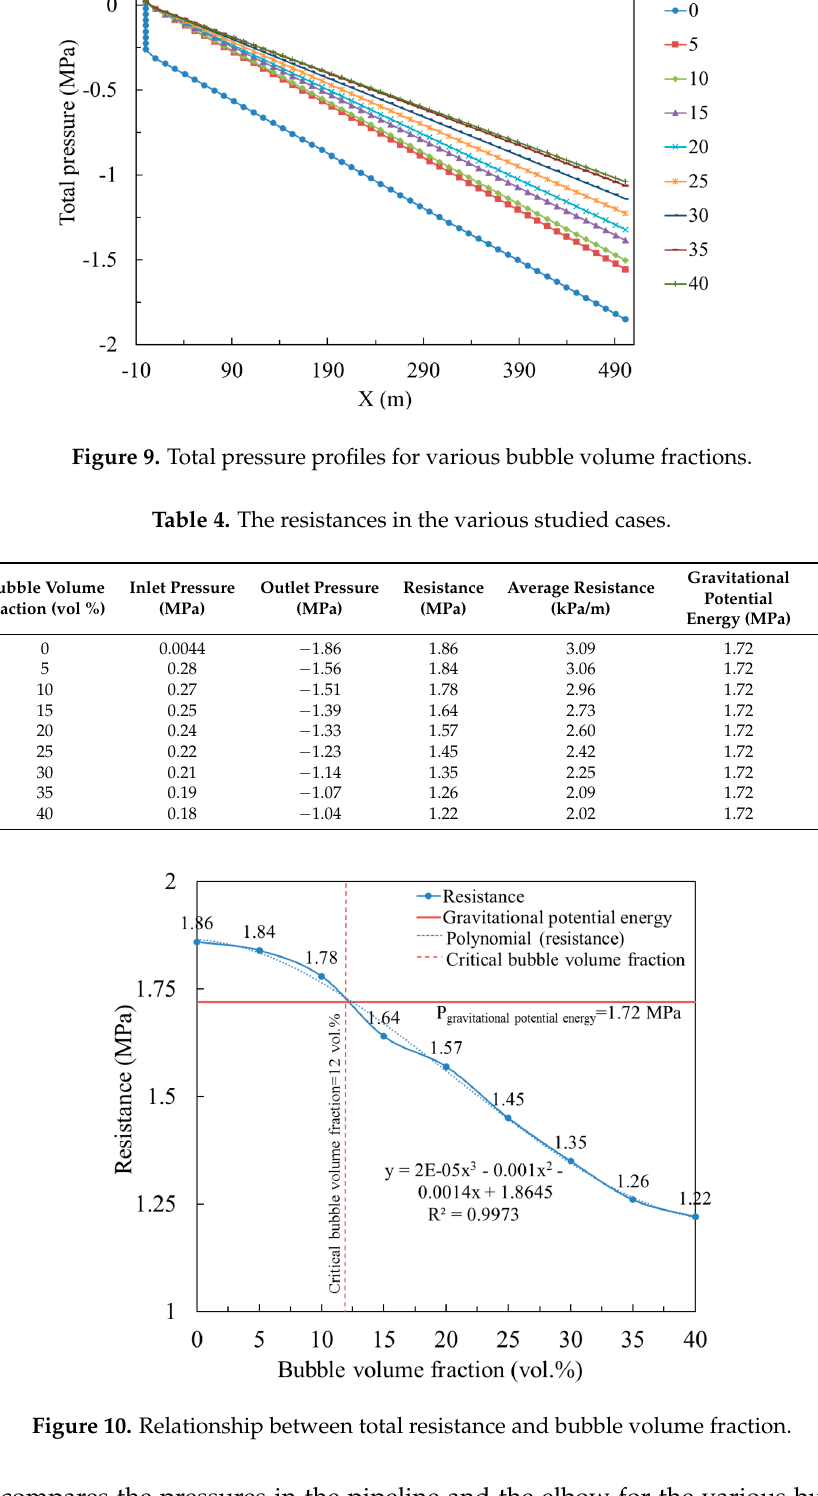
Table 4. The resistances in the various studied cases.